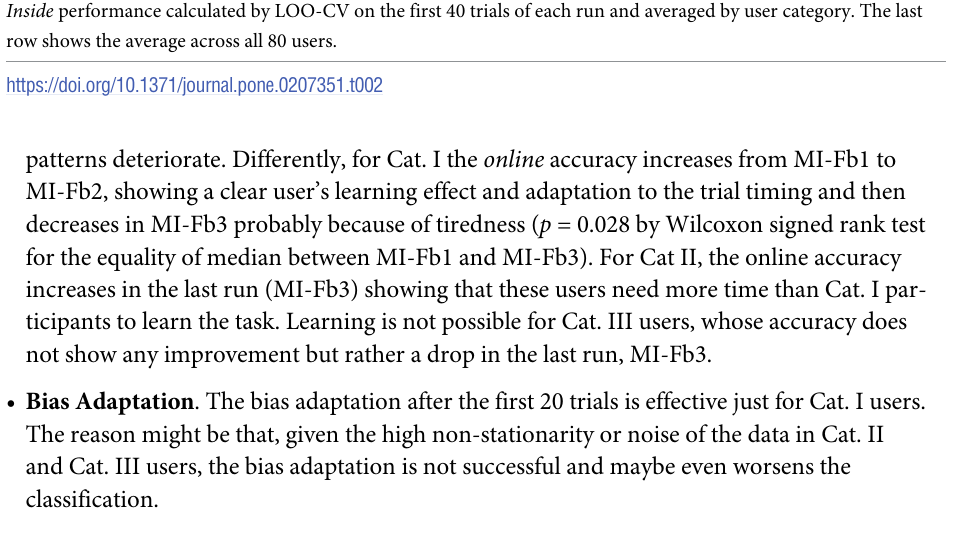
Inside performance calculated by LOO-CV on the first 40 trials of each run and averaged by user category. The last row shows the average across all 80 users.